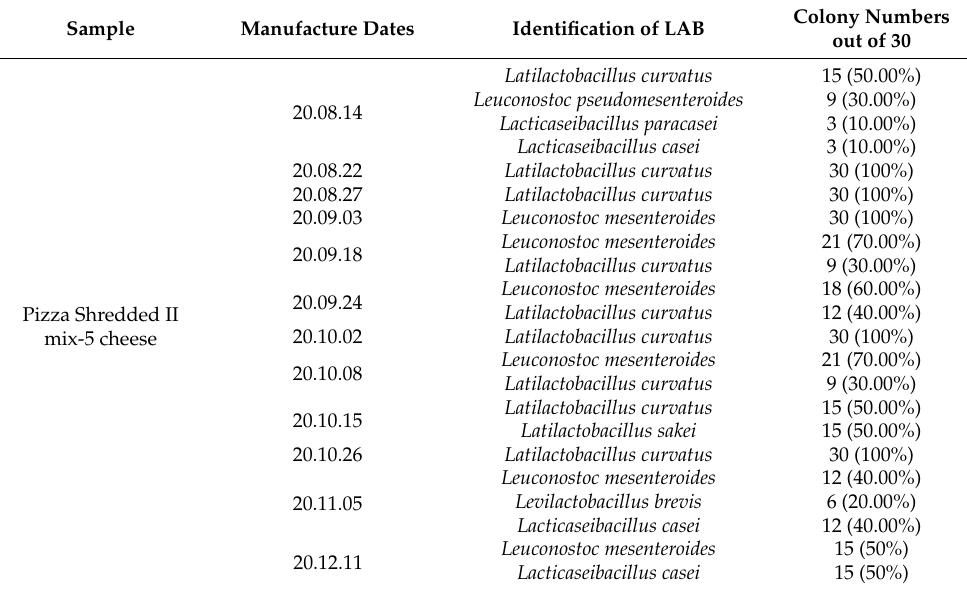
Table 2. Identification of LAB from Pizza Shredded II mix-5 cheese samples with different manufac- turing